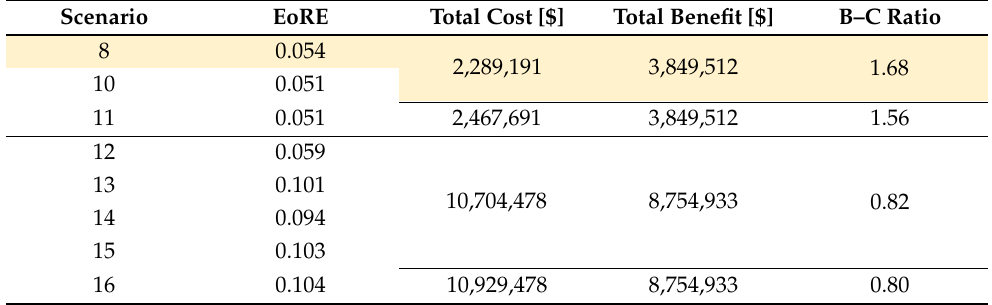
Table 4. CBA result that satisfied